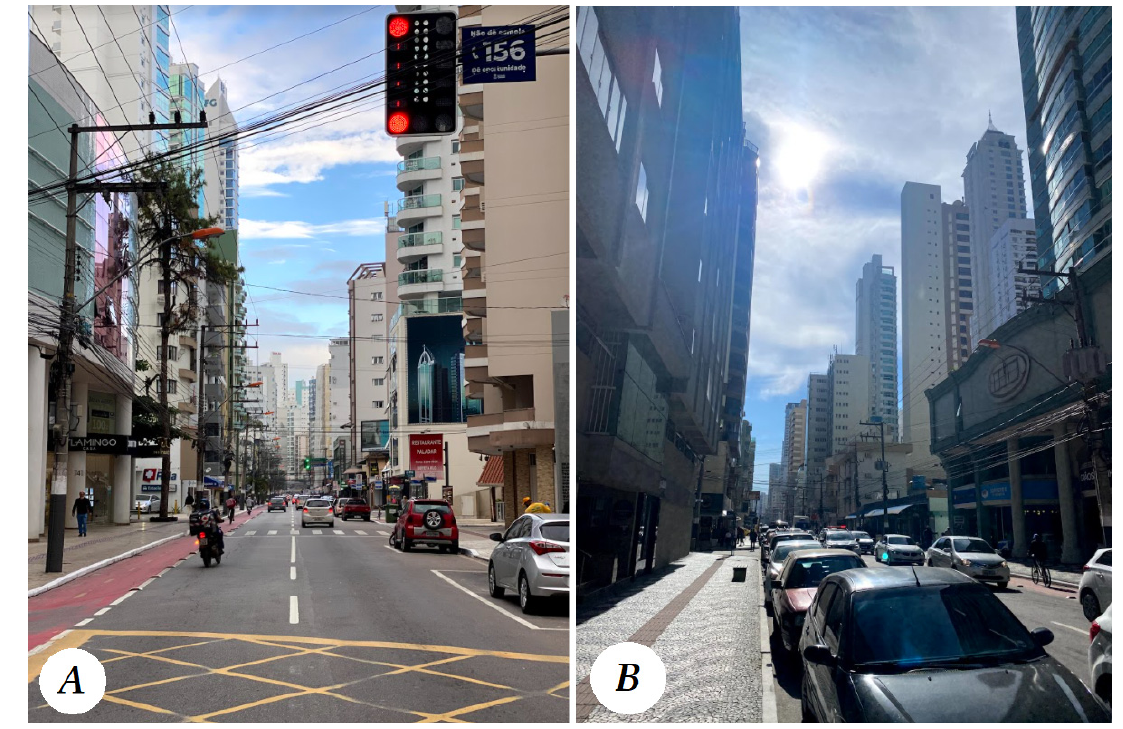
Figure 8. Images of Brasil Avenue. ( A ) North to south, and ( B ) south to north. Source: Authors, taken during fieldwork, August 2019.